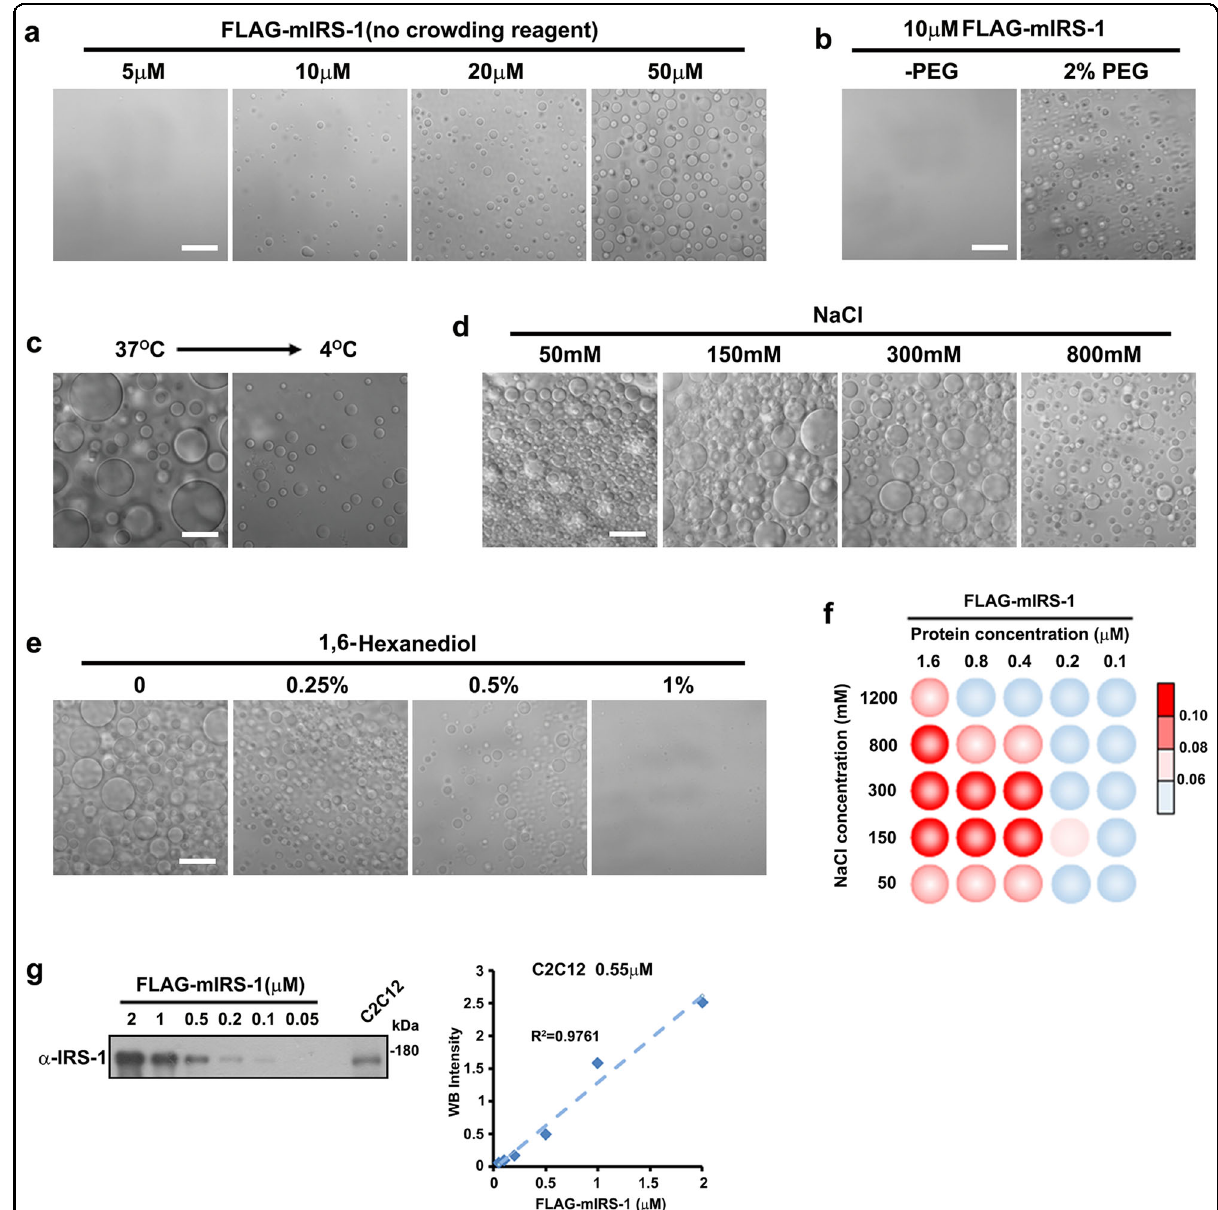
Fig. 2 IRS-1 undergoes phase separation in vitro. a DIC images of FLAG-mIRS-1 LLPS at a series of protein concentrations (5 – 50 μ M) (50 mM Tris- HCl pH 7.5, 10% glycerol, 1 mM DTT, 150 mM NaCl). The proteins were incubated with phase separation buffer at room temperature for 40 min. Scale bar, 20 µm. b DIC images of FLAG-mIRS-1 LLPS in the presence of molecular crowding (2% w/v PEG-8000) (right). No phase separation was observed without crowding agent (left). The proteins were incubated with phase separation buffer at room temperature for 5 min. Scale bar, 20 µm. c LLPS of mIRS-1 at 37 °C or 4 °C for 10 min. Scale bar, 20 µm. d DIC images of FLAG-mIRS-1 LLPS under different salinity, as indicated. The proteins (10 μ M) were incubated with phase separation buffer at room temperature for 20 min. Scale bar, 20 µm. e DIC images of FLAG-mIRS-1 LLPS with the addition of 1,6-hexanediol at indicated concentration. The proteins (10 μ M) were incubated with phase separation buffer at room temperature for 20 min. Scale bar, 20 µm. f Phase diagrams of GFP-mIRS-1 with concentrations ranging from 0.1-1.6 μ M in 50 mM Tris (pH 7.5), 2% (w/v) PEG-8000, and sodium chloride (ranging from 50 – 1200 mM). Blue dots indicate no phase separation. Red dots indicate phase separation. The LLPS ability of mIRS-1 under different conditions was color-coded on the basis of droplet turbidity as measured at OD600 when the proteins had been incubated with phase separation buffer at 37 °C for 120 min. g Quanti fi cation result of endogenous IRS-1 protein concentrations in C2C12 cells based on immunoblot densitometry analysis performed on cell lysates and puri fi ed FLAG-mIRS-1